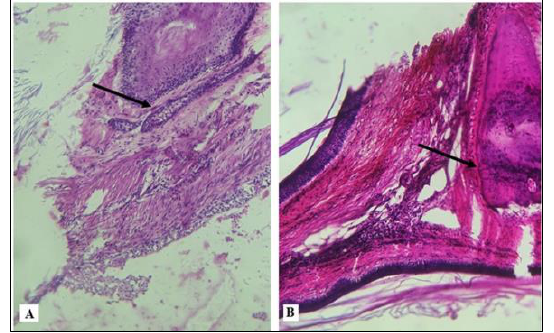
Figure 3: A) A cystic formation with localized mature skin tissue associated with sebaceous glands (arrow) arranged over mature smooth muscle tissue (HE × 100). B) Another area of the lesion showing mature bone tissue (HE ×